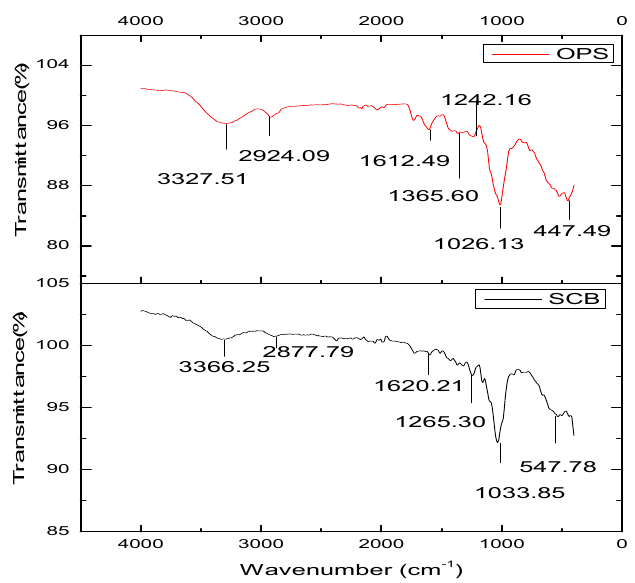
Figure 2. FTIR spectra of SCB and OPS.